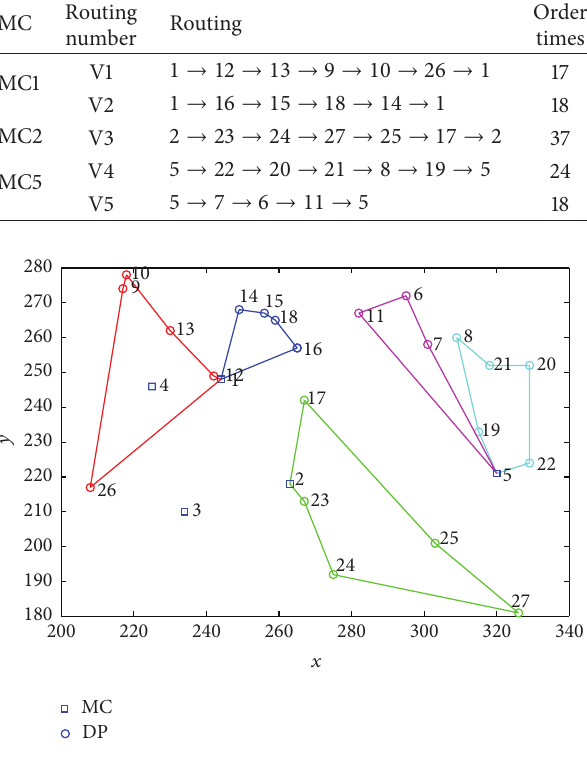
of HACO is significantly lower than ACO ( 𝑝 < 0.05 ); ( 2